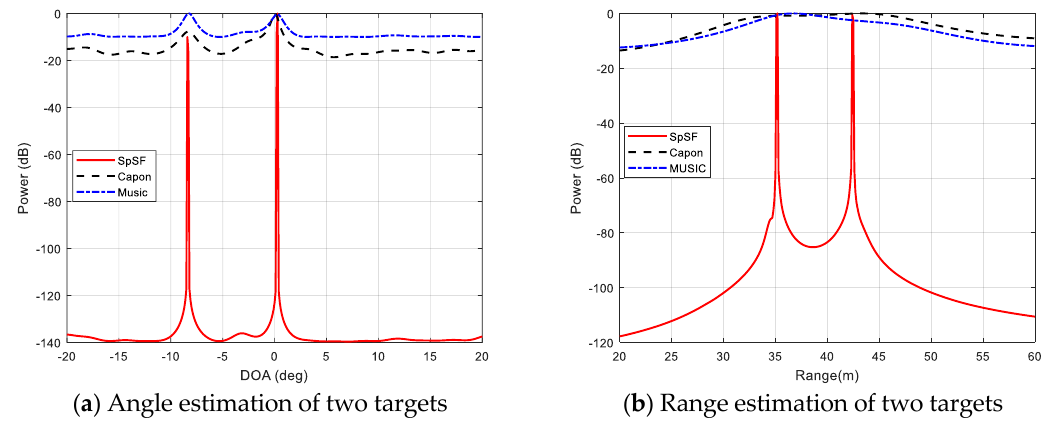
Figure 13. Scenario for the measured data set collection with 2 highlighted targets.